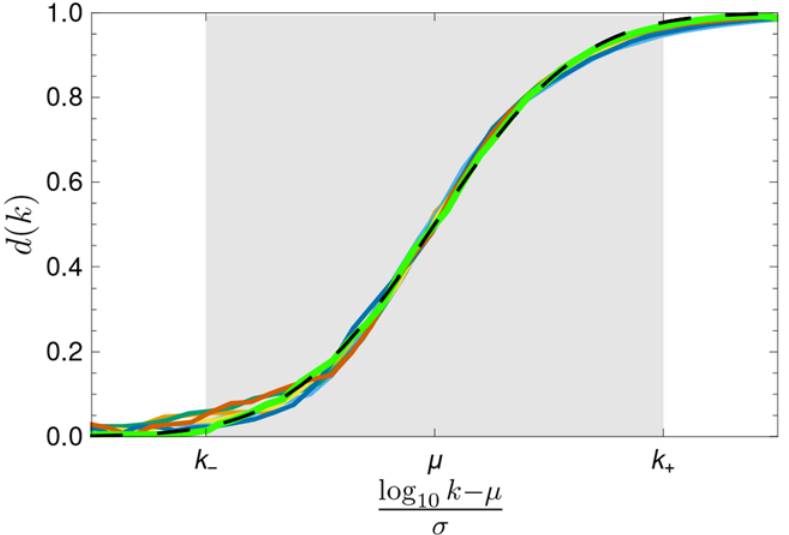
Fig 6. Rank diversity for the simulated language. The green curve represents the diversity corresponding to the language dynamics of a single realization of the Gaussian random walk model. We also include data for all languages studied, but normalized so that k ± coincide. The ansatz for the rank diversity is plotted as a parameter-free cumulative of a Gaussian with zero mean and unit variance as a dashed black